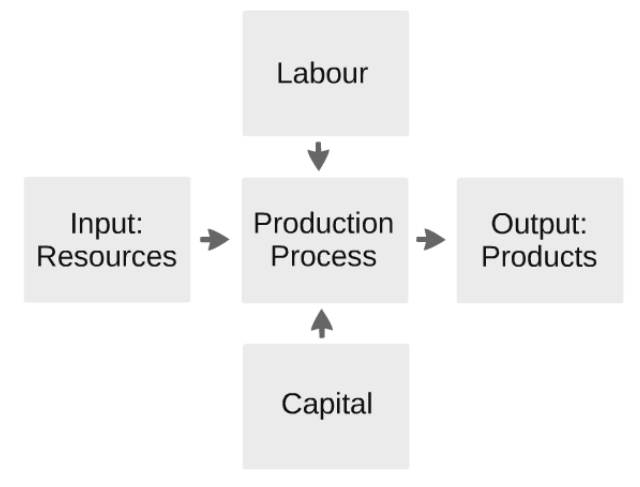
Figure 1: A basic structure of the production system Capital allowed for increased productivity of labour, higher production scale and, above all, worsening the two big issues humankind was already